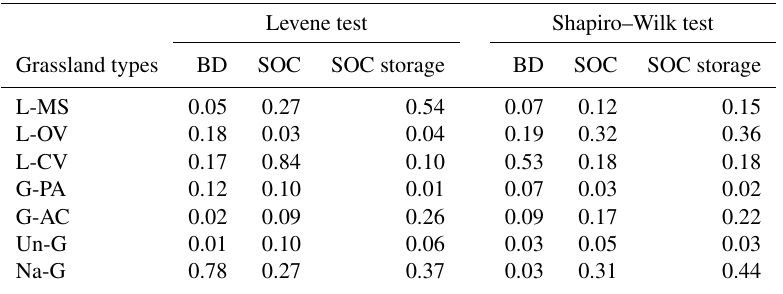
Table 2. The p values of homogeneity of variances by the Levene test and normality by the Shapiro–Wilk test in soil organic carbon content (SOC), soil C storage, and soil bulk density